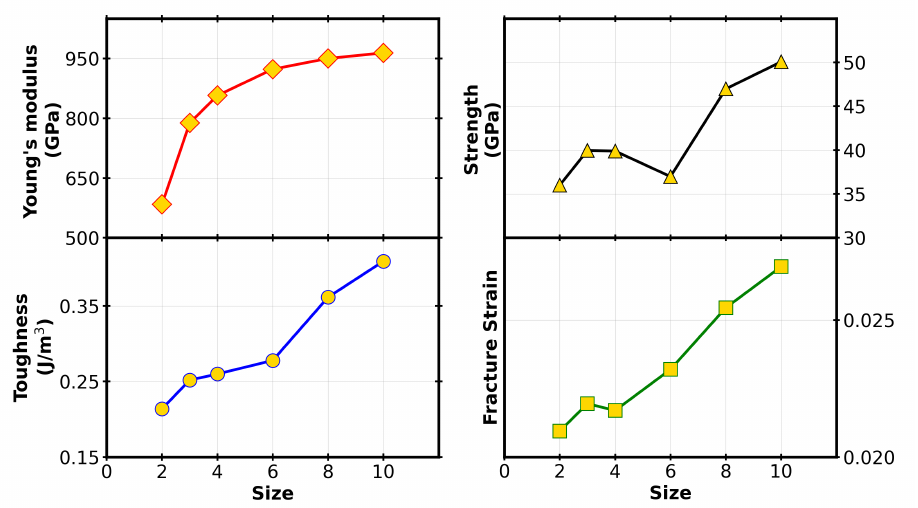
Figure 5. Size effects on mechanical properties under the condition of temperature T = 300 K, pressure P = 0.0001 GPa, strain rate 1 × 10 9 s − 1 , and crack length 2a 0 = 8